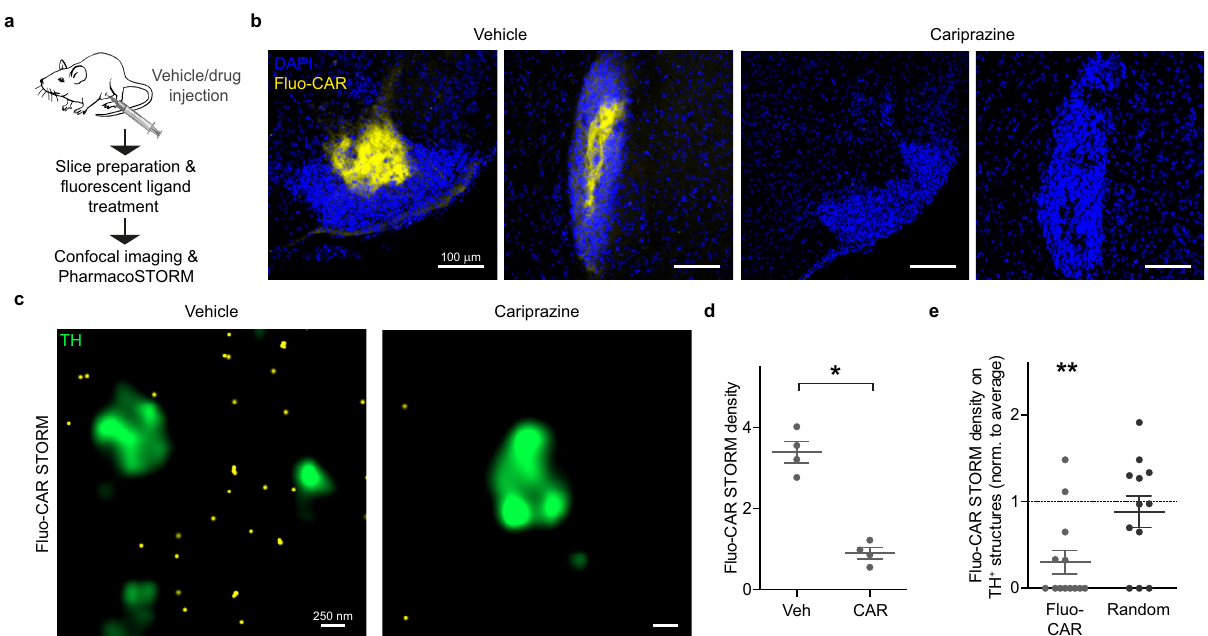
Fig. 5 Nanoscale visualization of in vivo cariprazine drug interaction sites by PharmacoSTORM. a Schematic illustration of the generalizable work fl ow that enables PharmacoSTORM-based quantitative nanoscale analysis of target engagement sites of drugs administered in vivo. In the speci fi c experiment, intraperitoneal injection of 1 mg/kg cariprazine was followed 2 h later by acute brain slice preparation and incubation with 30 nM Fluo-CAR. b Confocal images show that in vivo cariprazine pretreatment ef fi ciently blocks Fluo-CAR binding in the hilus of the Islands of Calleja. c Fluo-CAR binding sites (yellow) are visualized by PharmacoSTORM imaging. Note the striking lack of Fluo-CAR-binding sites on TH-immunopositive nerve terminals. In unlabeled cariprazine-treated animals, the density of STORM LPs representing Fluo-CAR-binding sites was markedly reduced, indicating that Fluo-CAR binding sites are preoccupied with cariprazine administered in vivo. d Scatter dot plot shows PharmacoSTORM density (LPs/ µ m 2 ) in the Islands of Calleja in cariprazine- or vehicle-treated animal pairs ( n = 4). Data are presented as mean ± SEM. Each data point represents the average density of STORM images obtained in the Islands of Calleja from each animal. Statistical evaluation was performed by two-tailed Mann – Whitney U test ( n = 4, P = 0.0286). e Statistical analysis of the nanoscale distribution of Fluo-CAR STORM LPs in relation to TH-immunopositive varicosities. The same analysis was applied as in Fig. 4d. The number of Fluo-CAR STORM LPs was signi fi cantly lower on TH-containing structures ( n = 12 frames, n = 4 animals). Two-tailed Wilcoxon signed-rank test was performed to test if the median of data is different from the hypothetical median of 1 ( P = 0.0057 for Fluo-CAR LPs, P = 0.5042 for random LP